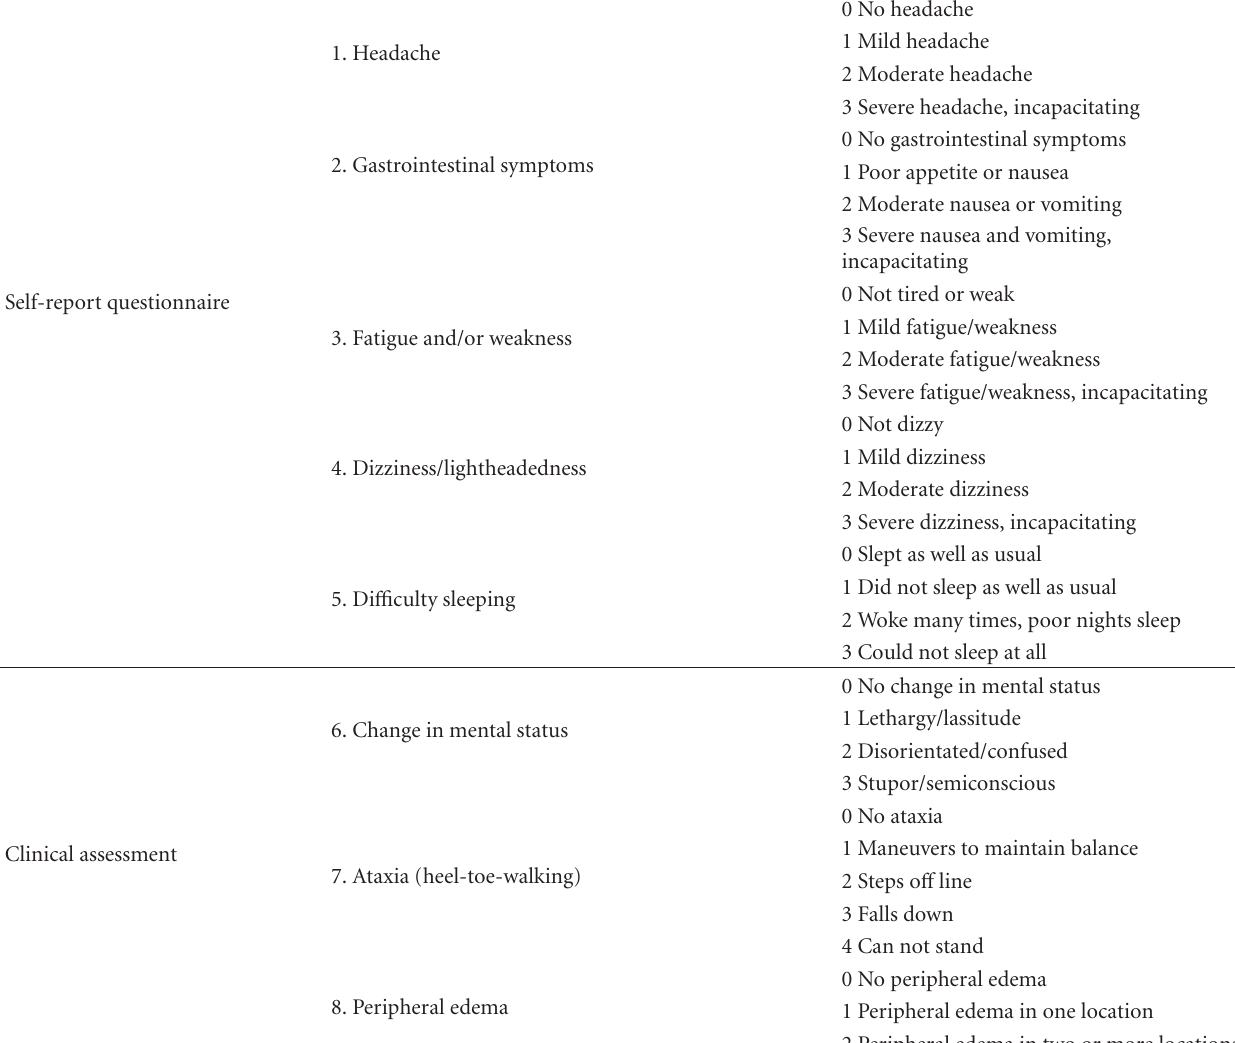
Table 1: Lake Louise score for detecting acute mountain